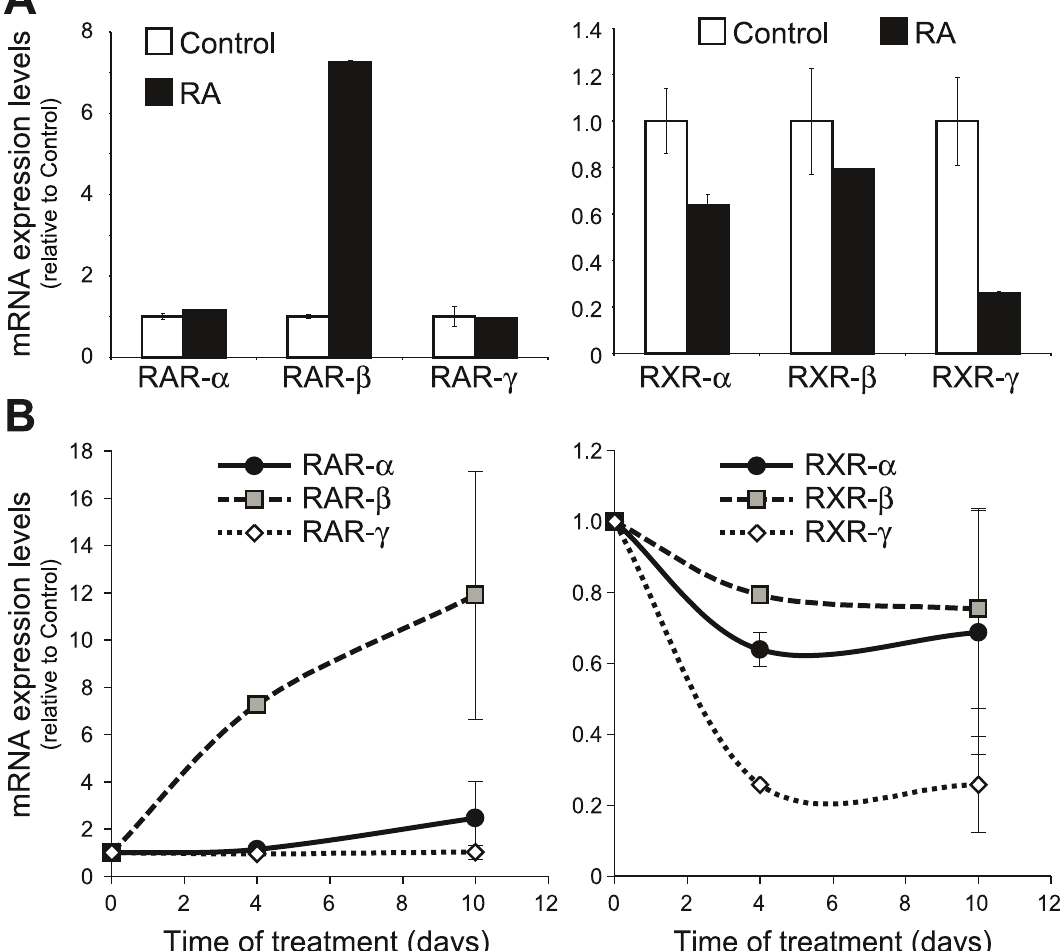
Figure 4. RA upregulates RAR- b and downregulates RXR- c in myelinating cocultures. ( A ) DRGN/SC cocultures were allowed to myelinate for 7 days in the presence or absence of 1 m M RA, and the relative levels of RAR- a , - b and - c , as well as RXR- a , - b and - c were determined by Q-RT-PCR. All values are shown as the mean 6 SD relative to their respective controls (sister cultures treated only with vehicle). ( B ) Myelinating cocultures were treated with 1 m M RA from the time of ascorbic acid induction and the levels of all six retinoid receptors were determined by Q-RTR-PCR at different times of treatment. All values are shown as the mean 6 SD relative to their respective controls (myelinating cocultures treated only with vehicle for the same length of